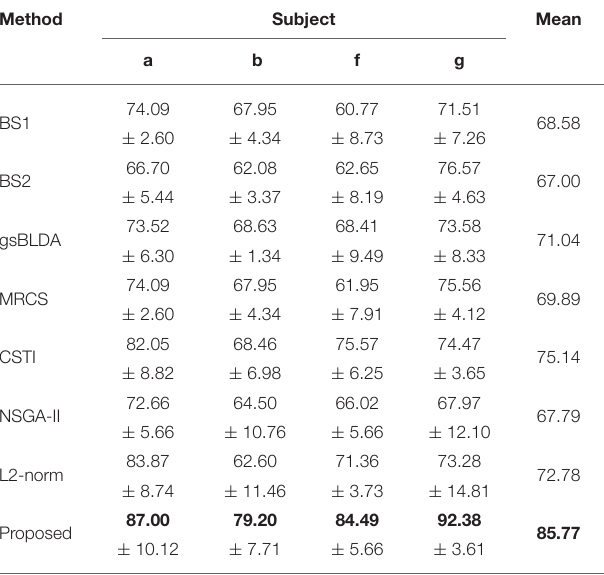
The best performance is highlighted in bold. Performance of BS1 and BS2 indicates classification accuracy with all channels and 3C channels, respectively. Performance of L2-norm indicates classification accuracy with L2 norm replacing L1 norm as the regularization term. TABLE 7 | The mean classification accuracy and standard deviation (%) of 5 cross-validation with the number of corresponding channels (listed in the bracket) of COL and baselines on 5 subjects of DS1 after using REST for zero-reference.